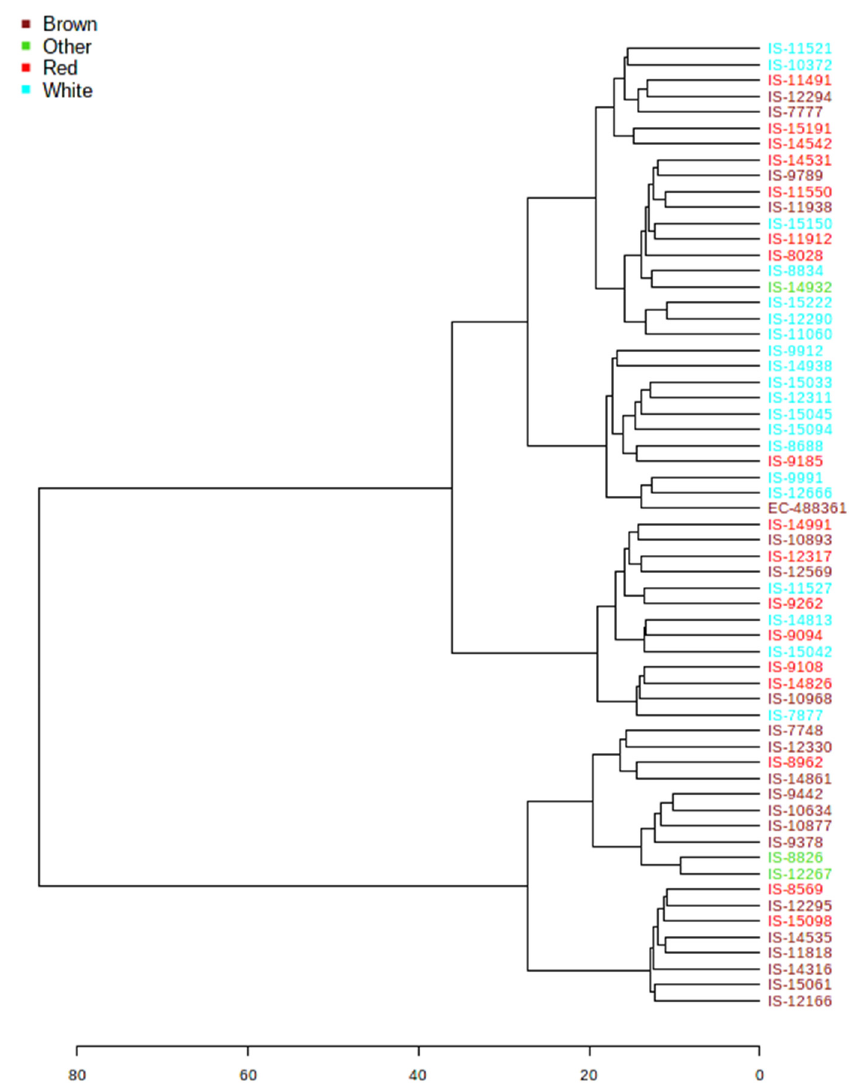
Figure 6. Hierarchical clustering of sorghum accessions based on its metabolite profiles.